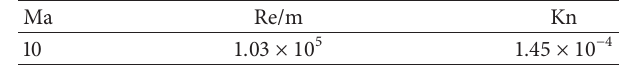
Table 7: Flow conditions of Edney’s type IV shock interaction. Ma Re/m Kn 10 1.03 × 10 5 1.45 × 10